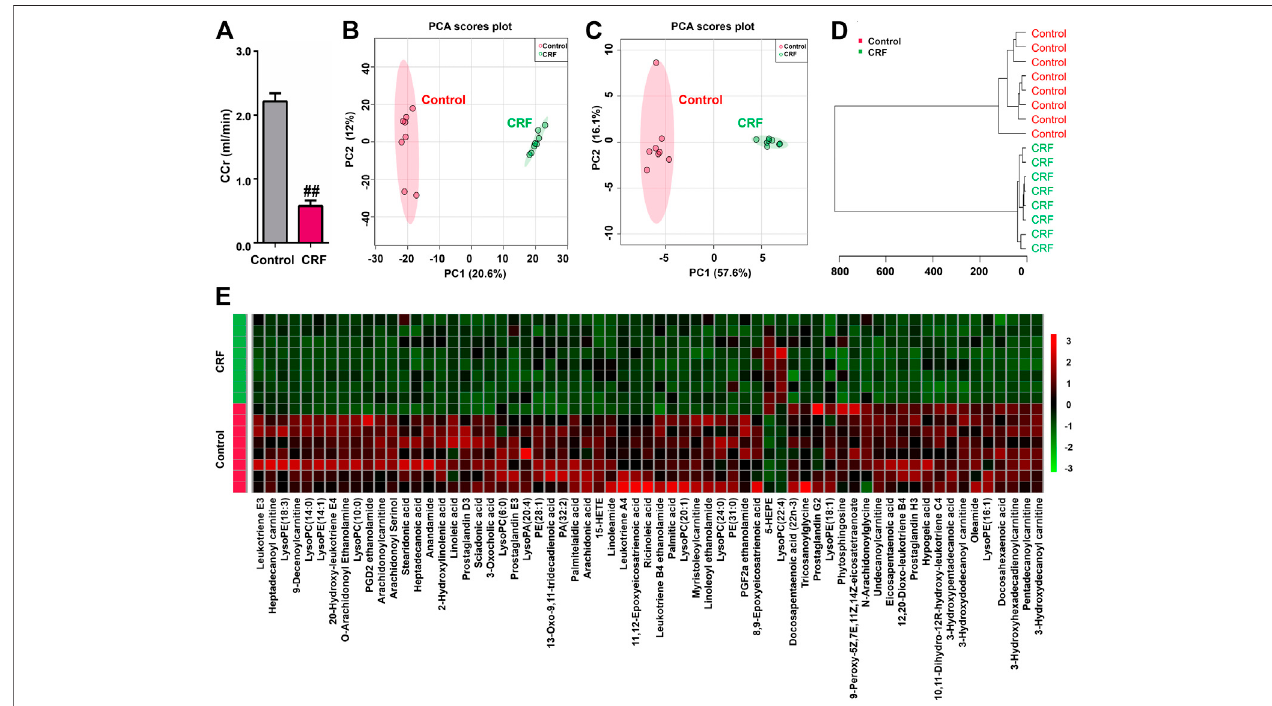
FIGURE1| Adenineledtodecliningrenalfunctionandchangedlipidmetabolicpro fi linginCRFrats. (A) CCrinthecontrolandadenine-inducedCRFgroups. ## p < 0.01comparedwithcontrolgroup. (B) PCAoftwocomponentsof2193variablesfromcontrolandadenine-inducedCRFgroups. (C) PCAoftwocomponentsof65lipid speciesfromcontrolandadenine-inducedCRFgroups. (D) Clusteringanalysisof65lipidspeciesformcontrolandadenine-inducedCRFgroups. (E) Heatmapof65lipid species between control and adenine-induced CRF groups. Red and green indicate increased and decreased levels, respectively.